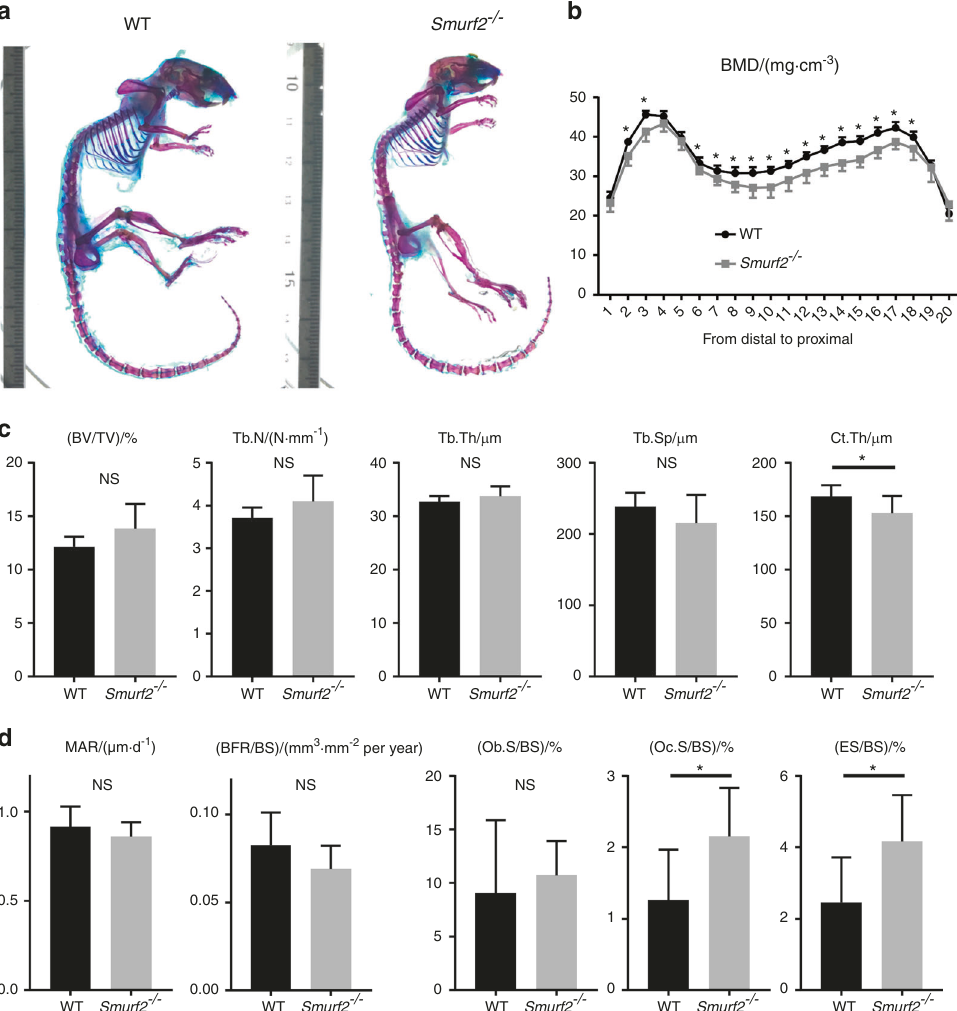
Fig. 1 Skeletal evaluation. a Whole skeleton mouse littermates of either genotype. b BMD of femurs from 12-week-old mice of either genotype as determined by micro-CT analysis. The femurs were scanned in 20 longitudinal sections. The BMD of each section was measured from the distal to the proximal femur. c Micro-CT analysis of distal femurs from 12-week-old mice of either genotype. d Bone histomorphometric analysis of proximal tibias from 12-week-old mice of either genotype. ( n = 8 per genotype; * P < 0.05; NS, not signi fi cant by Student ’ s t